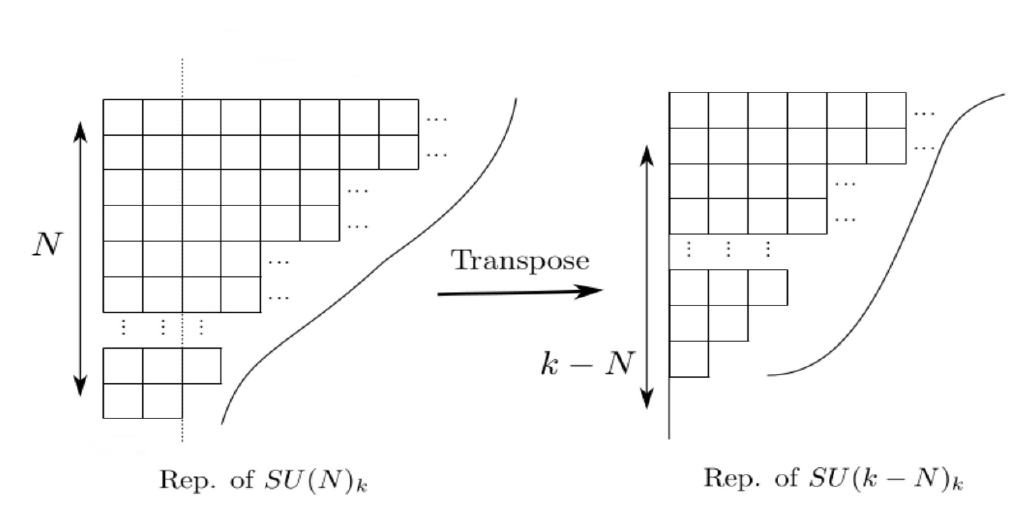
Figure 6 . Level-rank duality and transposition of Young